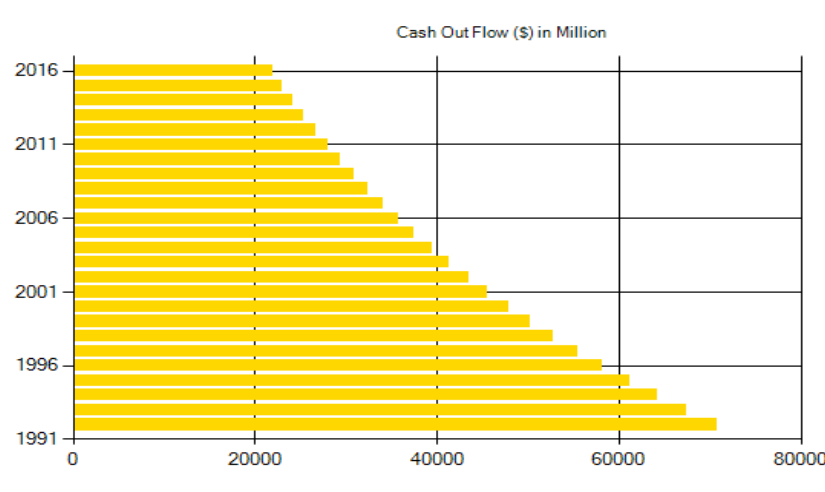
Figure 7. SPECA Model Cash outflow